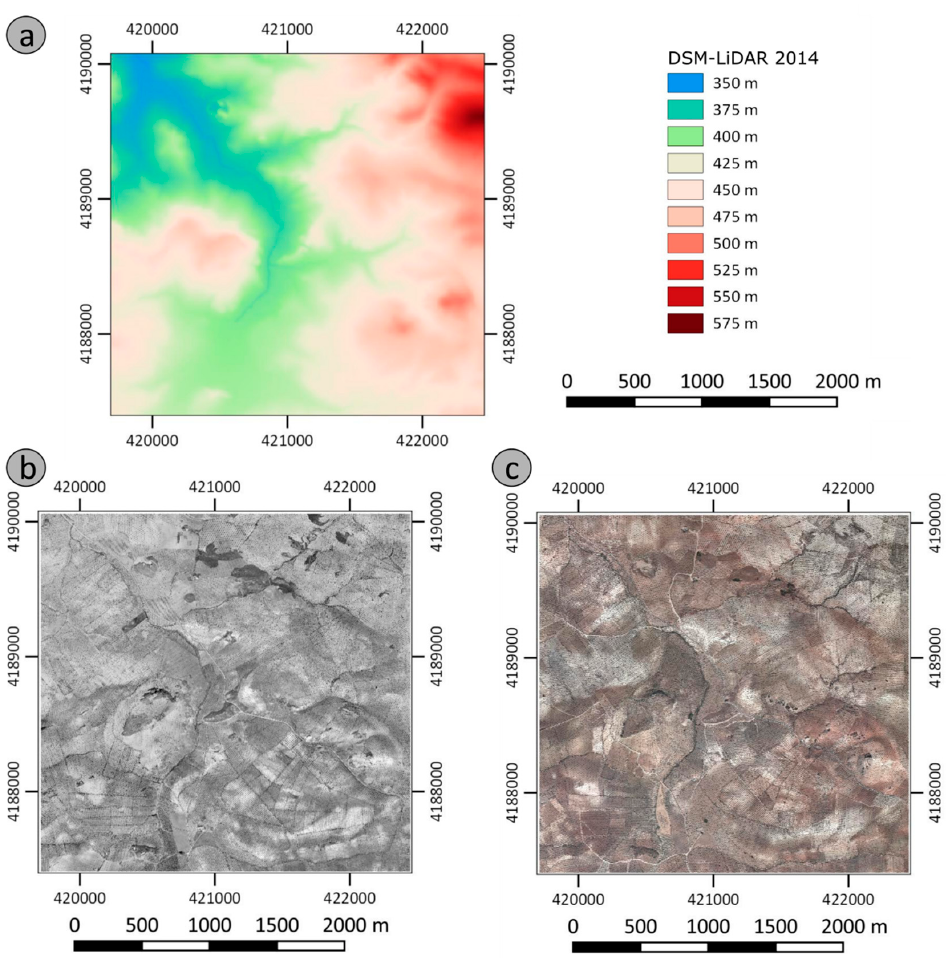
Figure 5. DSMs and orthophotographs: ( a ) DSM derived from LiDAR data (2014); ( b ) orthophotograph of 1980; ( c ) orthophotograph of 2016. Coordinates are in ETRS89-UTM30.